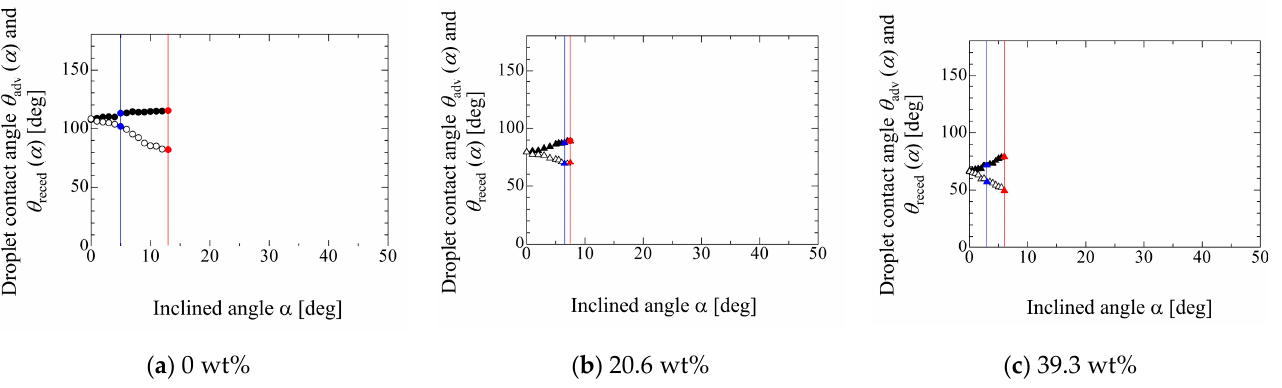
Figure 7. Effect of the liquid property on the changes in the contact angles. The blue and red solid lines represent the front and rear contact lines movement, respectively.